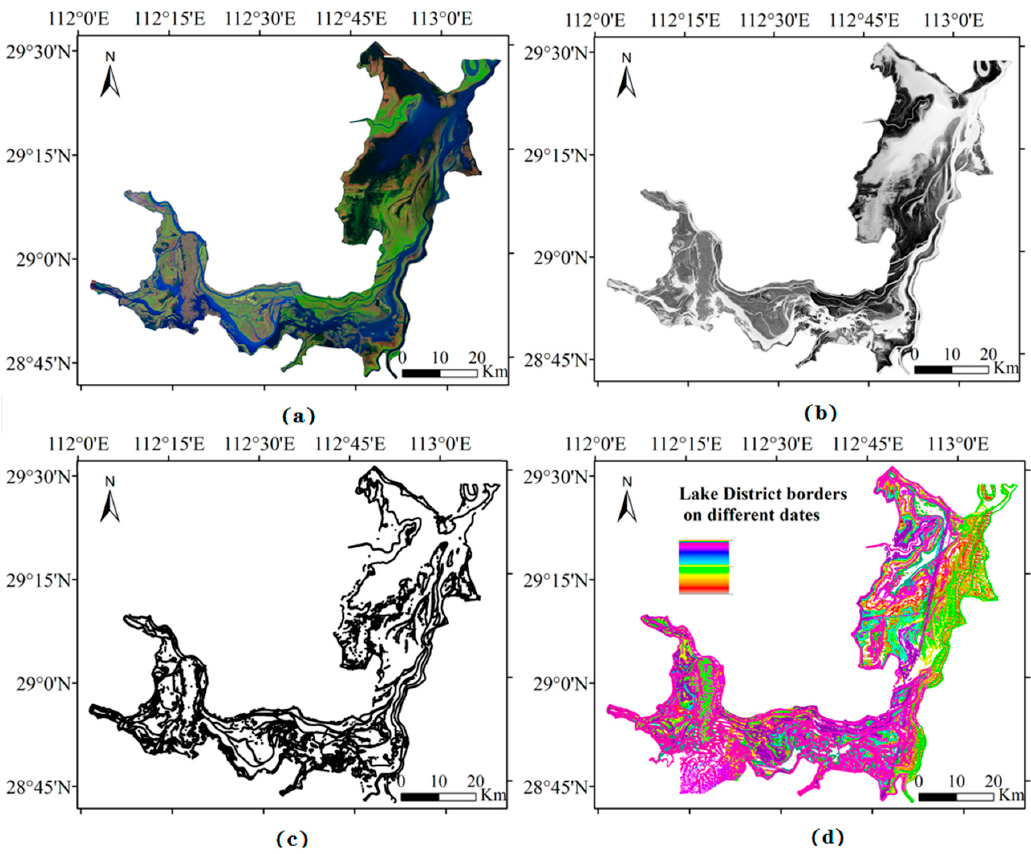
Figure 7. Landsat remote sensing image processing: ( a ) Landsat Thematic Mapper red–green–blue imagery; ( b ) improved waterbody index (AWEI); ( c ) Landsat ETM lake boundary extraction; ( d ) superimposed effect of the lake boundary in multi-day.